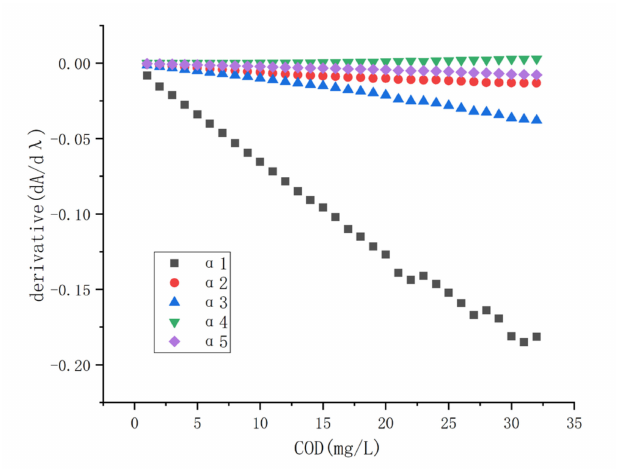
Figure 9. The linear relationship between the COD and α i ( i = 1,2,3,4,5 ) . Table 4. The correlation coe ffi cient between COD concentration and α i ( i = 1,2,3,4,5 ) . Characteristic Points